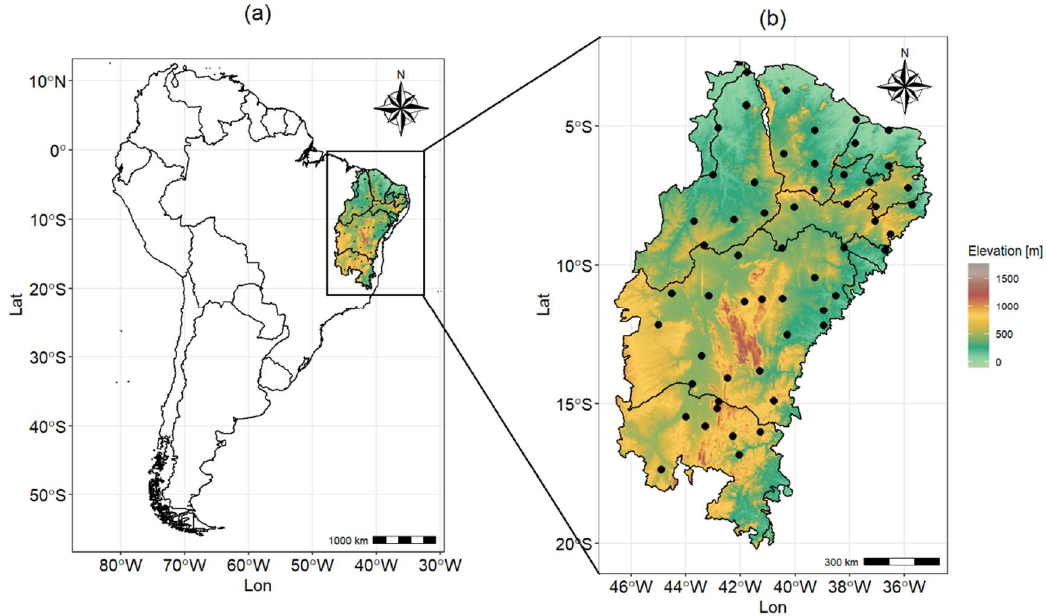
Figure 1. ( a ) Limits of South America and Brazil. ( b ) Limits of the Brazilian semiarid region and its topography with the geographic location of the rain gauges used in the study. topography with the geographic location of the rain gauges used in the